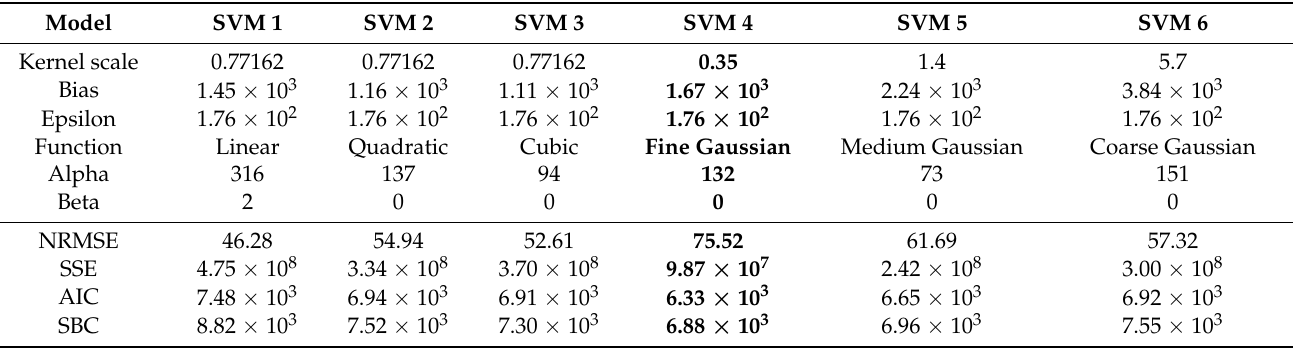
Table 6. Overview of the parameters of the created SVM models and performance metrics of the DMSP-40 muscle validation